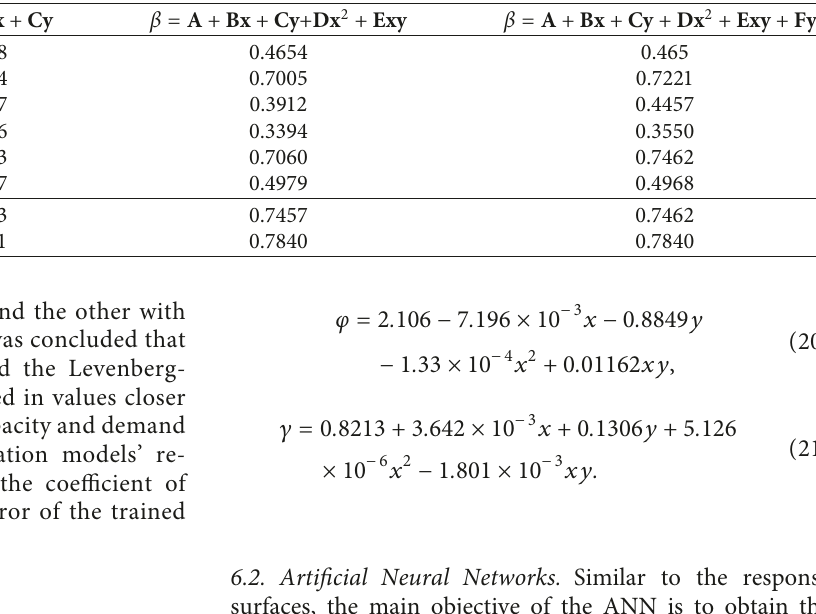
Table 4: Coefficient of determination for the structural reliability